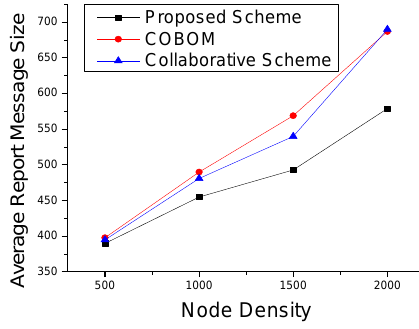
Figure 15. Averaged report message sizes with different node densities.